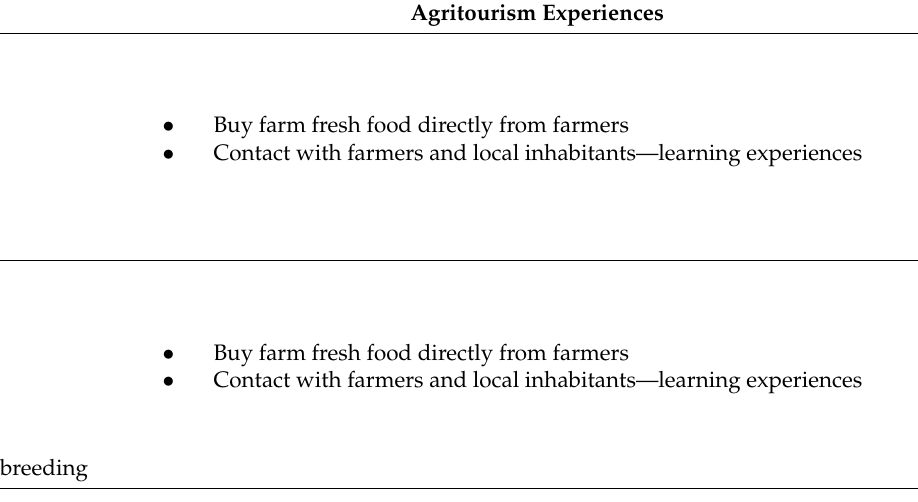
Table 8. Agritourism experiences with positive relationships with landscape typologies